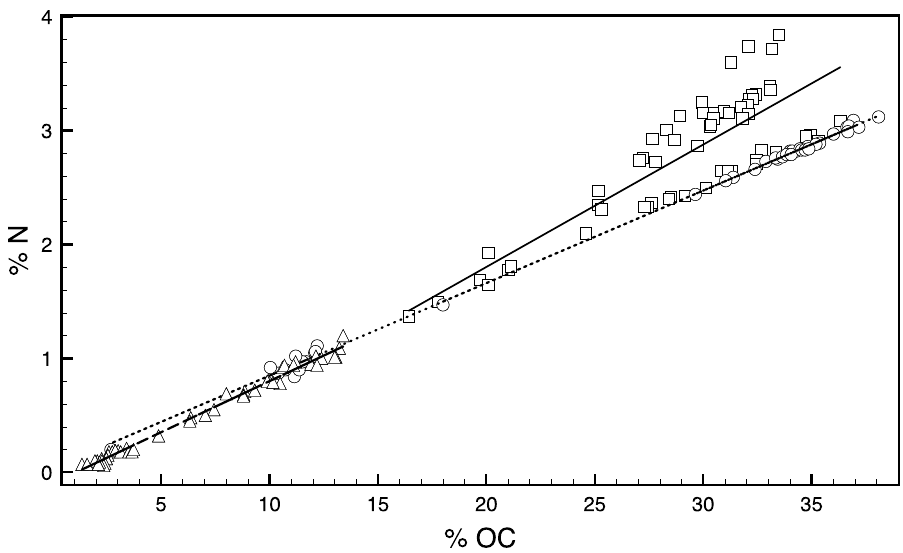
Fig 7. Plot of total organic carbon percent versus total nitrogen. The plot is divided according to core zone: zone 1, squares with solid trend line (R 2 = 0.72, b = -0.72), zone 2, circles with dashed trend line (R 2 = 0.99, b = 0.03), and zone 3, triangles with dotted trend line (R 2 = 0.99, b = -0.09). For all samples R 2 = 0.95 and b =